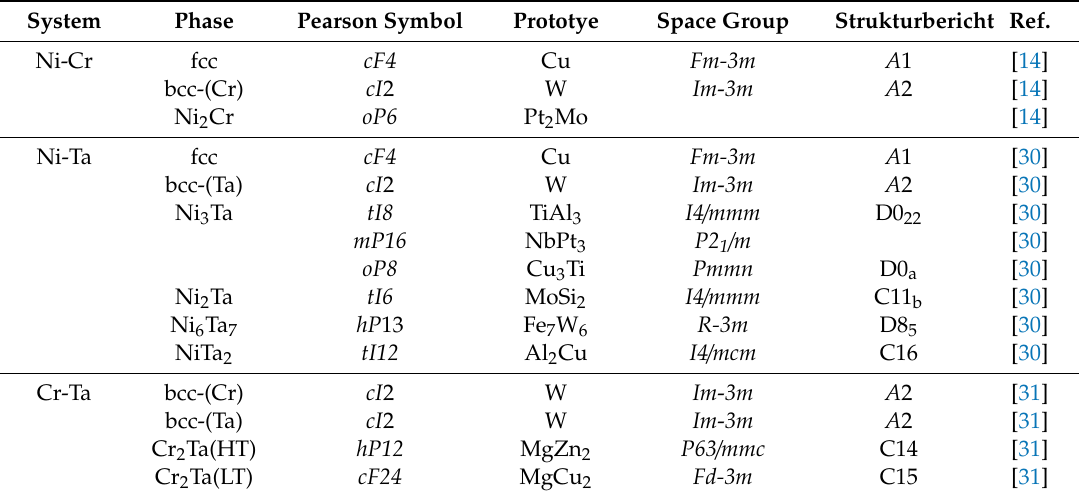
Table 1. The stable solid phases in the Ni-Cr-Ta ternary